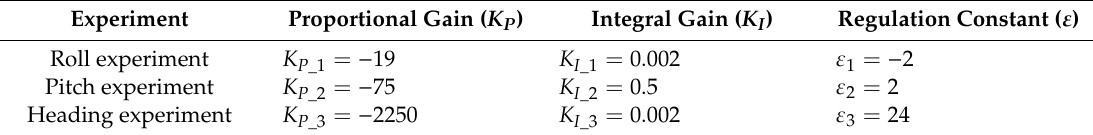
Figure 5. Estimated heading, before and after proposed method compared to the iPhone reference. Table 2. Parameters of PI controller and regulator for each static orientation experiment.